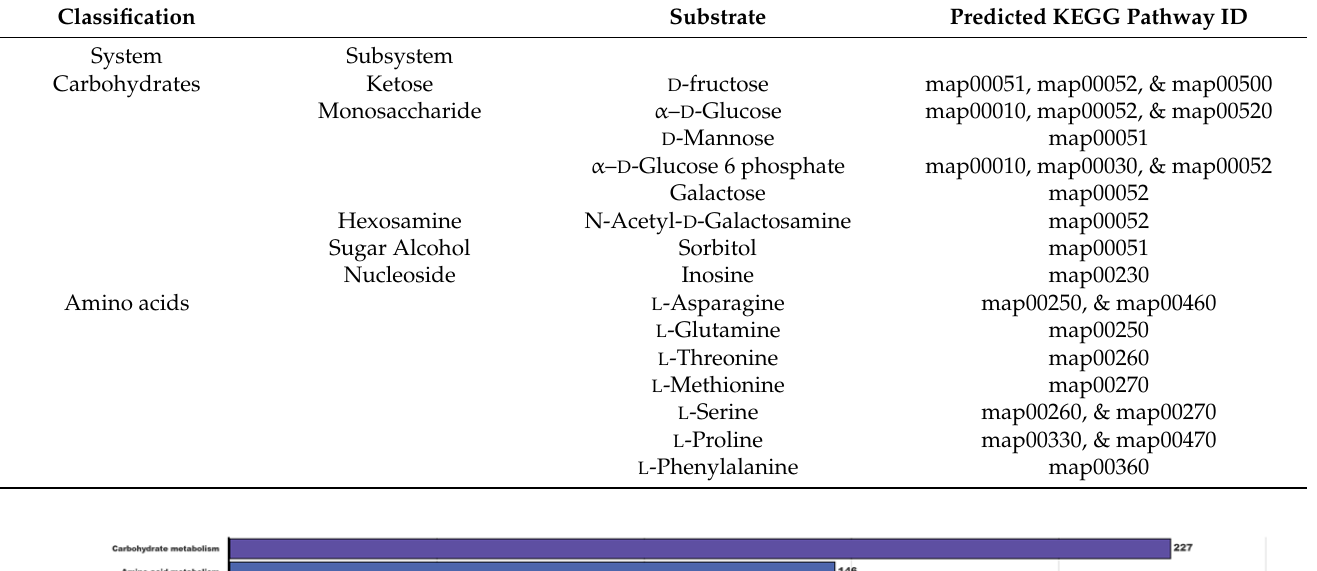
Table 5. Substrate utilization profile of the P. bifermentans GBRC as obtained by AN-Biolog ® Plate as well as genomic approach.